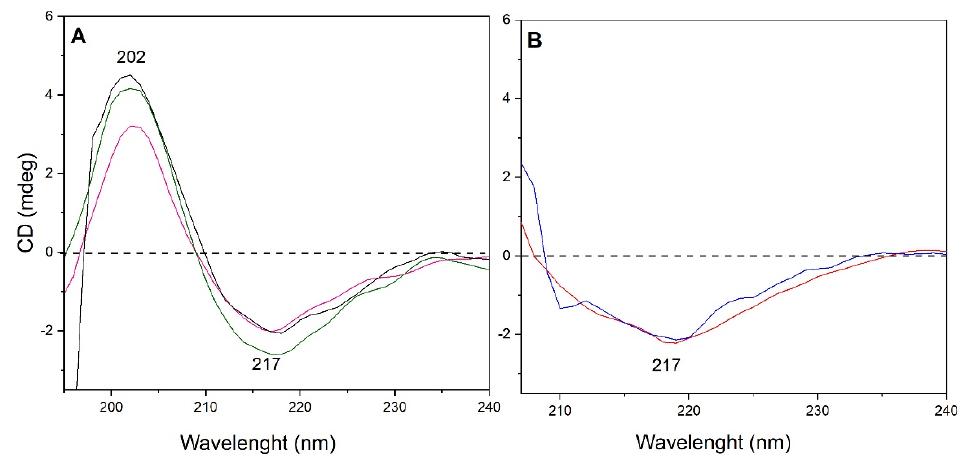
Figure 2. CD-UV spectra of BVZ ( A ) in a vehicle (green curve), normal saline (black curve), and phosphate buffer (magenta curve) and of BVZ ( B ) in the form of an ion pair (red curve) and after a break of ion pair (blue curve).